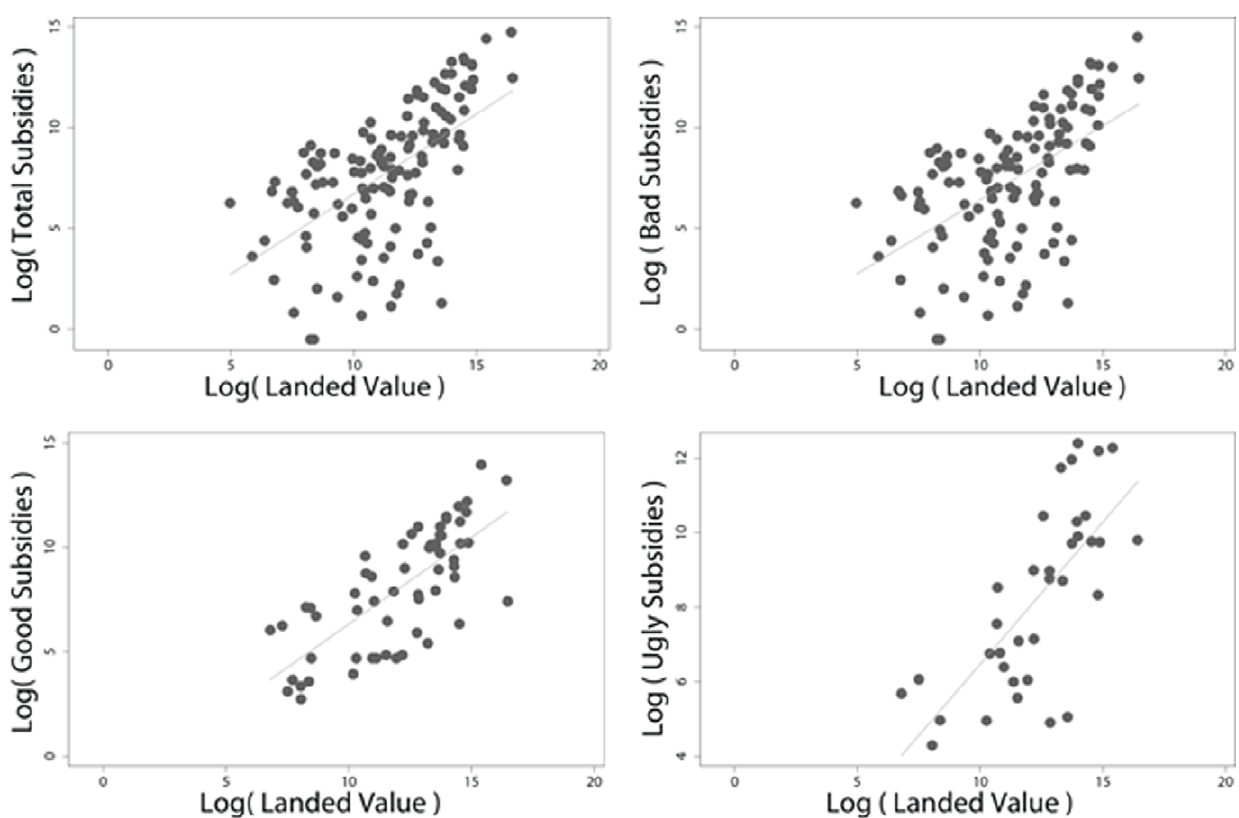
Figure 8. Correlation between reported subsidies [ 17 ] and landed-value [ 16 ] .